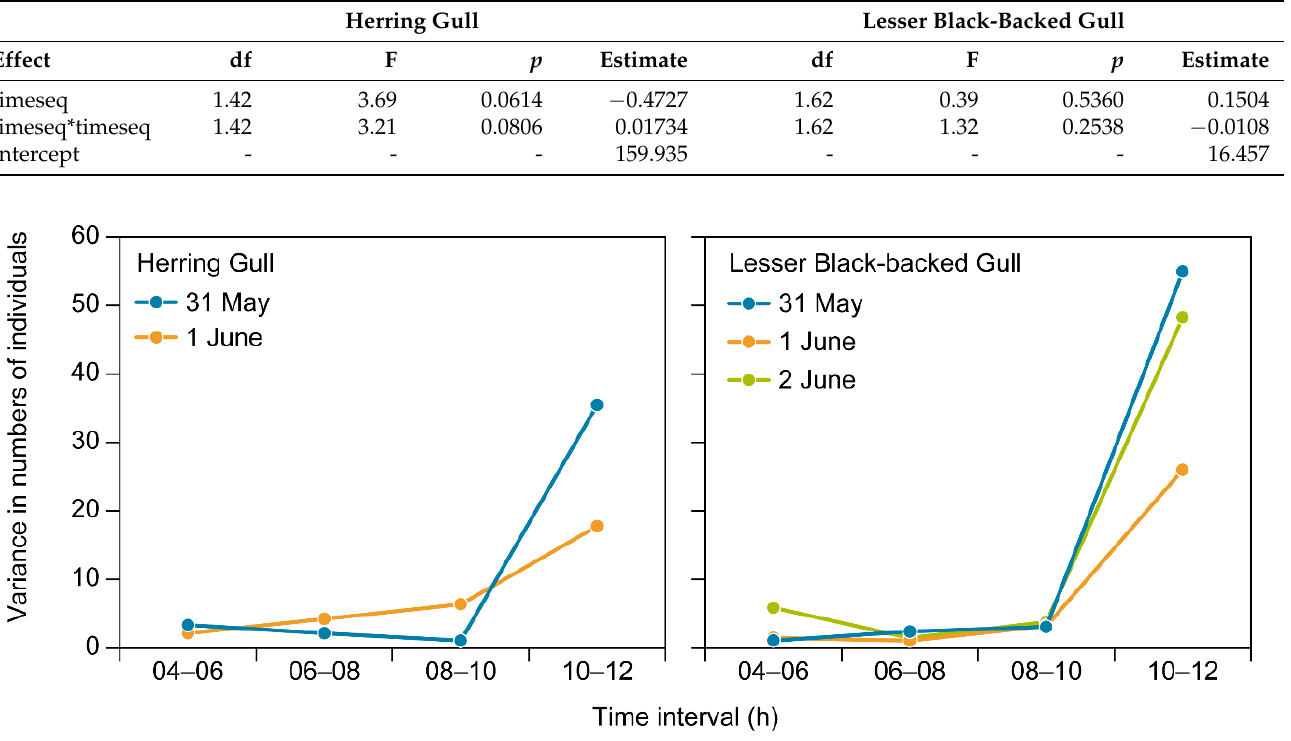
Figure 4. Variation in numbers of Herring Gulls ( left figure ) and Lesser Black-backed Gulls ( right figure ) present inside the two study plots from early morning to midday given for the four 2-h intervals on 31 May and 1 June (HG) and 31 May – 2 June (LBBG).